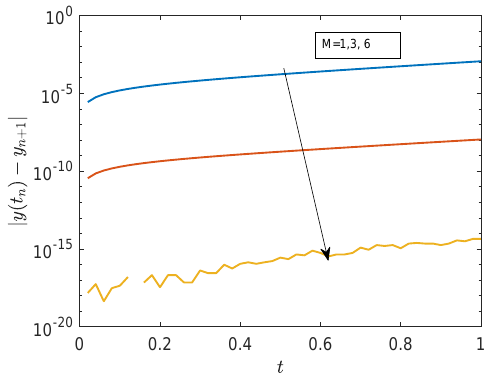
Figure 1. Errors for example 1.